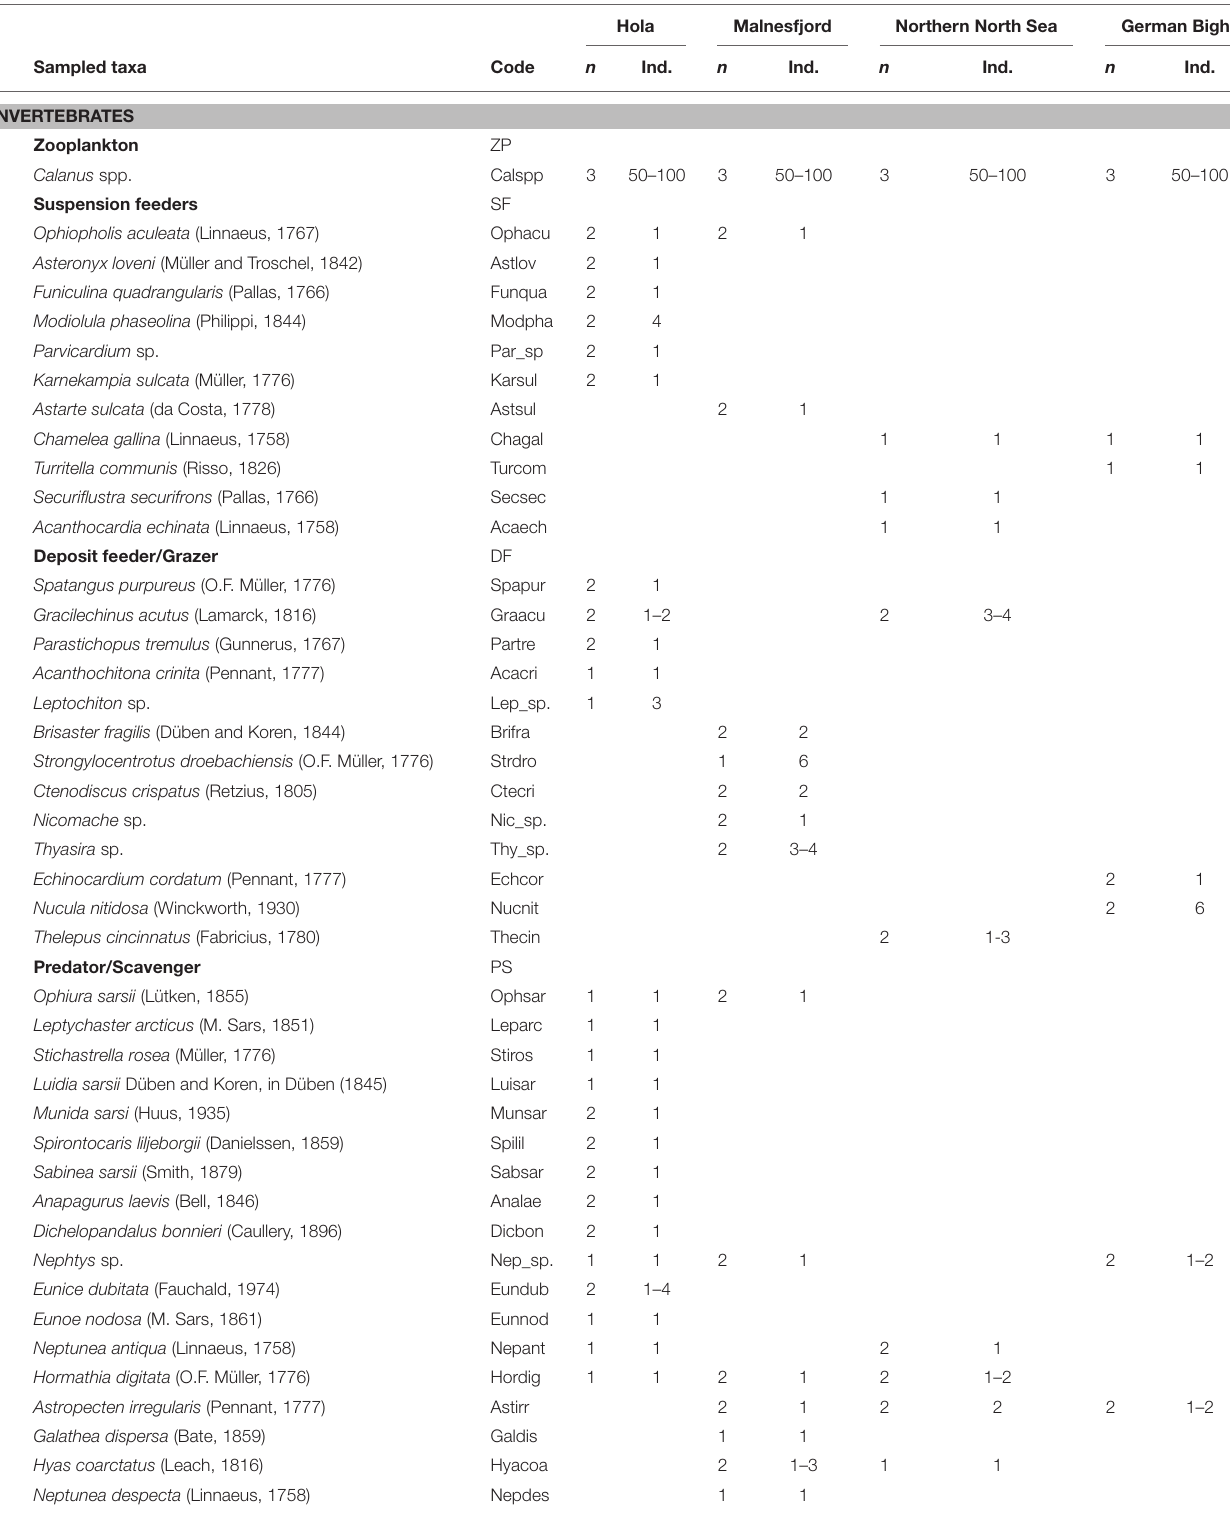
TABLE 1 | Sampled taxa and sample preparation information.